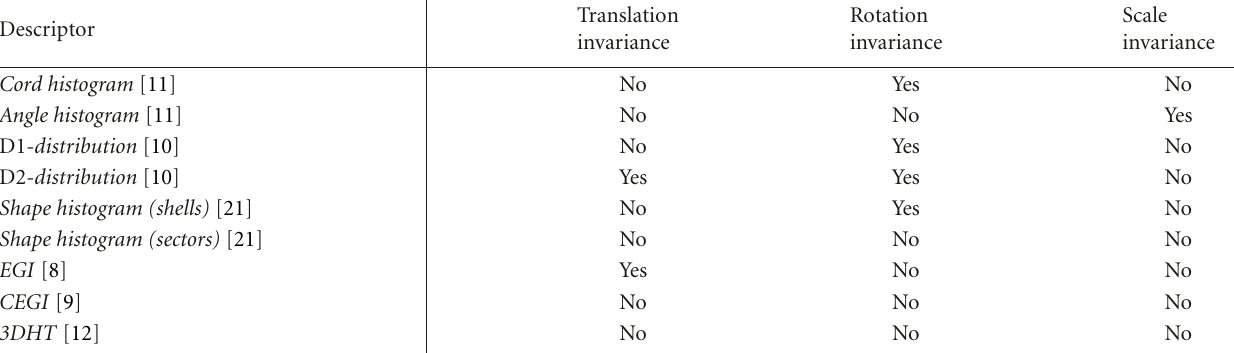
Table 1: Invariance properties of histogram-based 3D shape